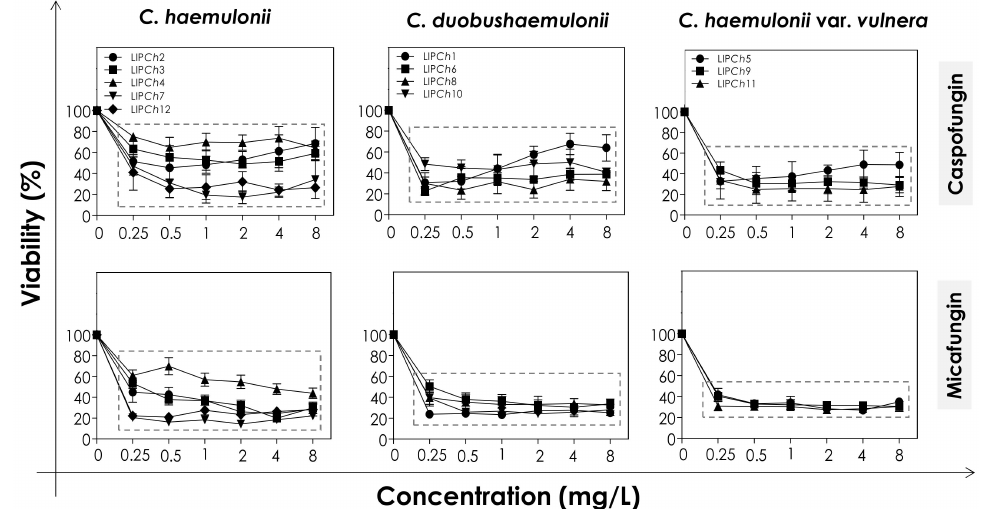
Figure 1. Cell viability of biofilms formed by clinical isolates comprising the C. haemulonii complex exposed to di ff erent concentrations of echinocandins (caspofungin and micafungin). The results were assessed spectroscopically (492 nm) by XTT reduction and expressed as the mean of metabolic activity percentages compared to untreated biofilms (control), which correspond to 100%. The graphs exhibit the mean ± standard deviation of three independent experiments. The dashed boxes represent the concentrations of echinocandins that caused statistically significant reduction of cell viability in relation to the respective control ( p < 0.05; One-way ANOVA analysis of variance, Dunnett’s multiple comparison test).